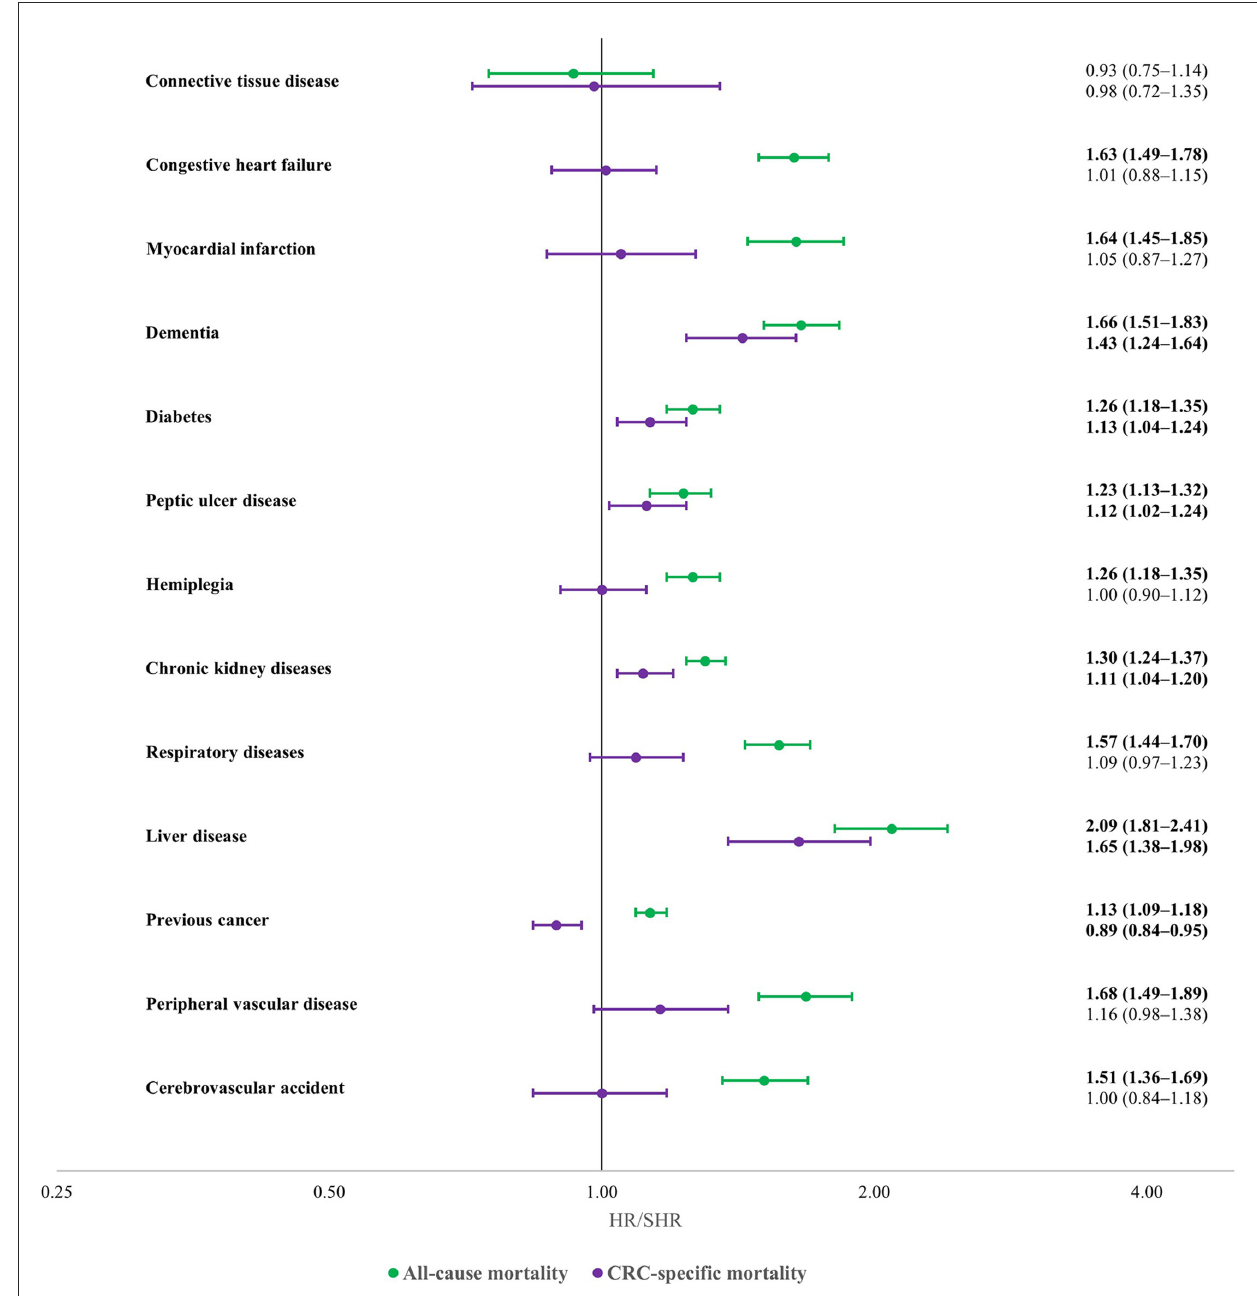
FIGURE2 Associations of specific comorbidities with all-cause (green) and CRC-specific (purple) mortality in CRC cases (multivariable regression): South Australia, 2004–2013 diagnose, date of censoring December 31, 2014 adjusted for age, stage, primary subsite, grade, socioeconomic and remoteness status, diagnostic period, sex. Statistically significant results are shown with bold font. All-cause mortality outcomes are reported as hazard ratio (HR), and CRC-specific mortality outcomes are reported as sub-distribution hazard ratio